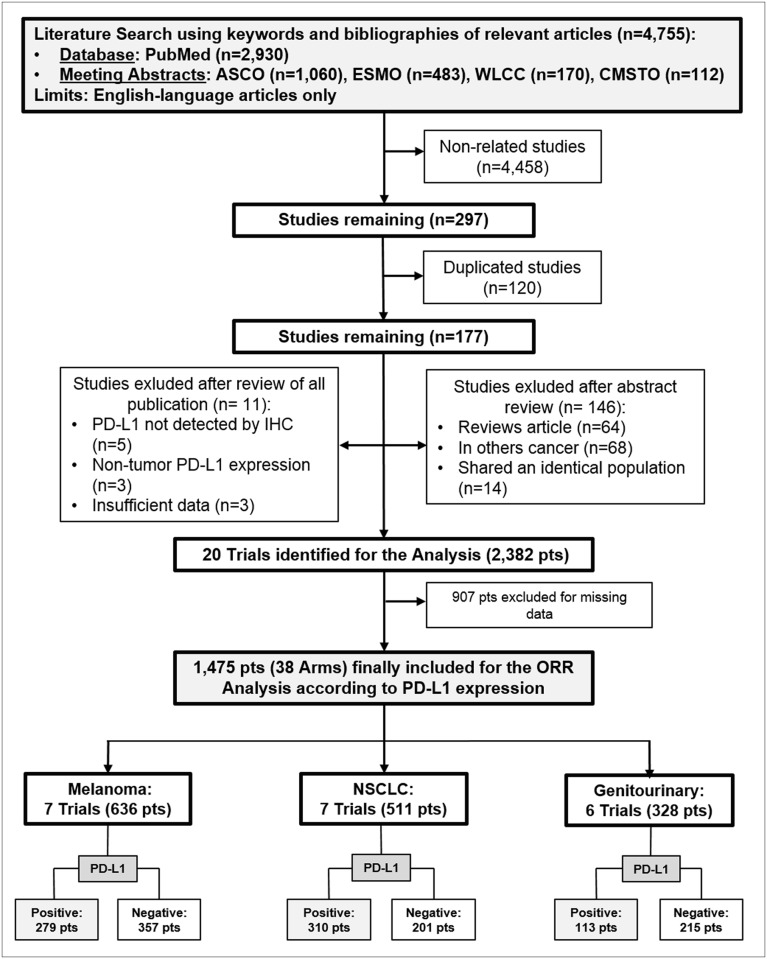
Outline of the search—Flow chart of the studies included in the analysis.Pts: patients; n: number; PD-L1: programmed death-ligand-1; IHC: immunohistochemistry; ORR: overall response rate; NSCLC: non-small cell lung cancer.